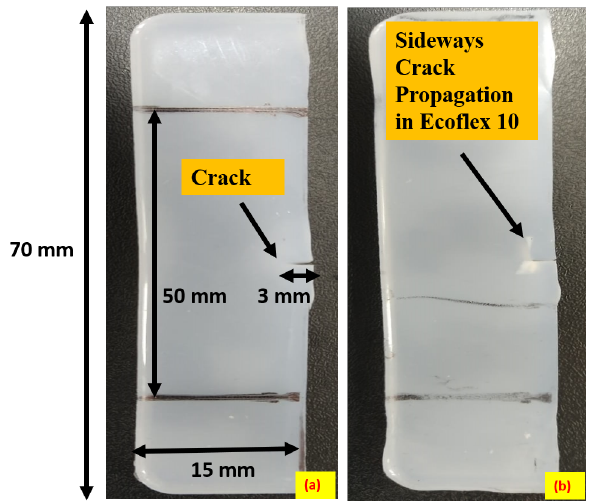
Figure 5. Representation of sideways crack propagation of Ecoflex 10 of thickness 3.6 mm at a strain rate of 40 mm/min; ( a ) initial cut in the specimen; ( b ) specimen after sideways crack